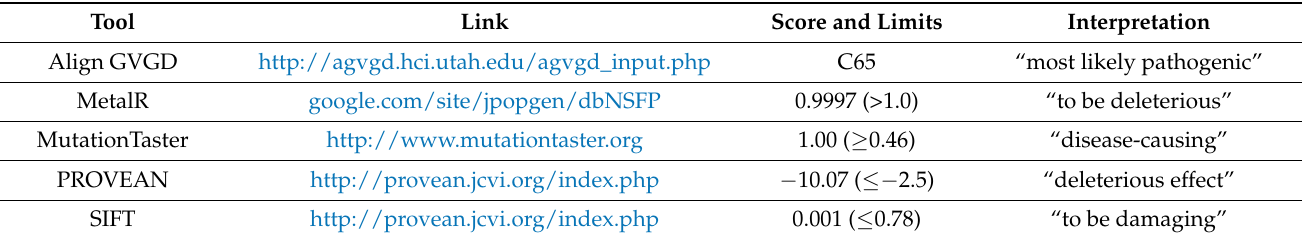
Table 2. In silico online prediction